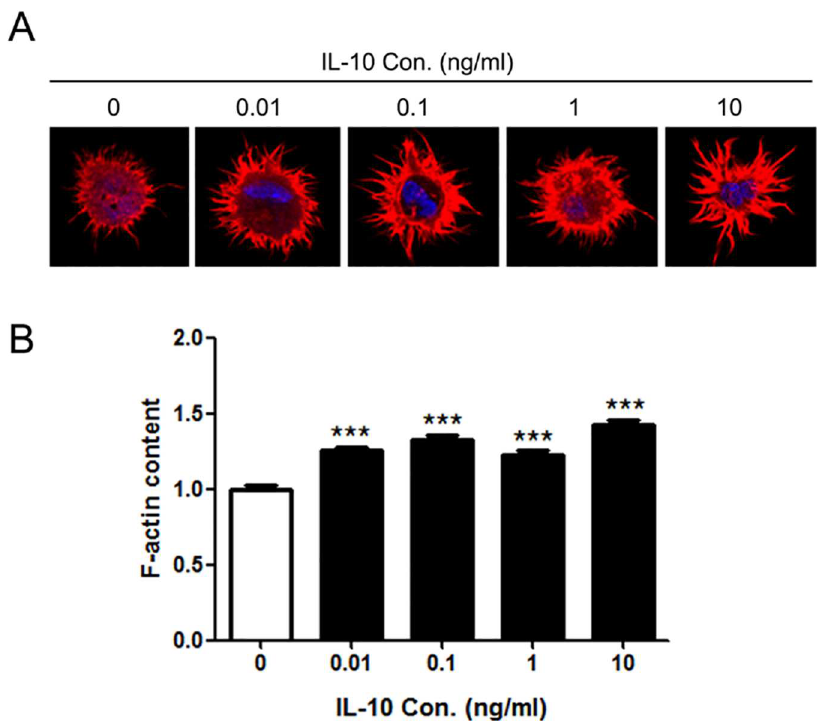
Fig 3. The effect of IL-10 on the F-actin content of mDCs. (A) The F-actin organizationof mDCs treated by different concentrations of IL-10. Cells were labeledwith rhodminephalloidinand photographed by a confocalmicroscope (600 × ). (B) F-actin contents of IL-10-treated mDCs. F-actin contents were quantifiedby measuring the mean fluorescent intensitiesof F-actin. Comparedwith control group: *** p <